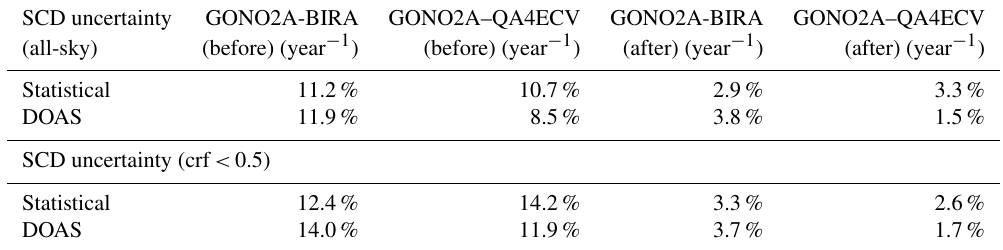
Table 7. Yearly increase of the statistical and DOAS uncertainty estimates for the sub-periods before and after the second throughput test (September 2009) for GOME-2A NO 2 SCDs from GONO2A-BIRA and GONO2A–QA4ECV (Pacific orbit from day 1 of January, April, August, October (or closest available data) 2007–2015) for all-sky conditions (top panel) and clear-sky conditions (bottom